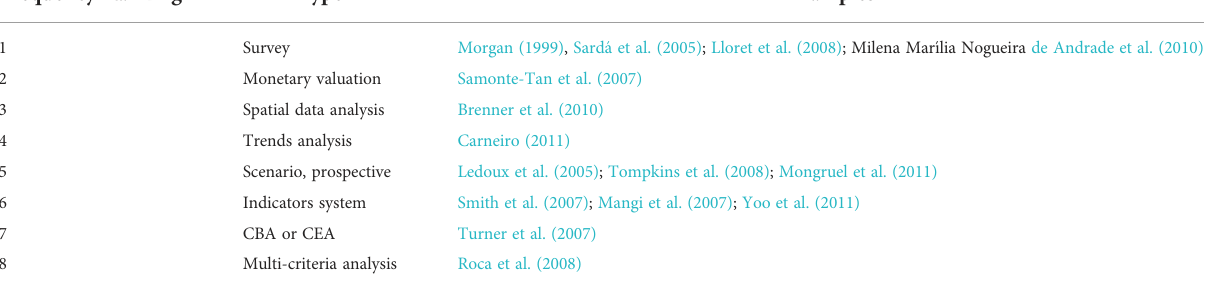
TABLE 1 Literature on Socio-economic